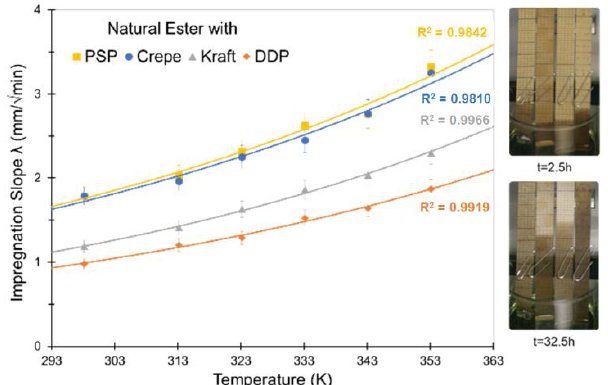
Figure 2. Impregnation slope of a natural ester in different kinds of paper [37]. The complete study is reported in [37]. Reprint with permission [37], Copyright 2019,